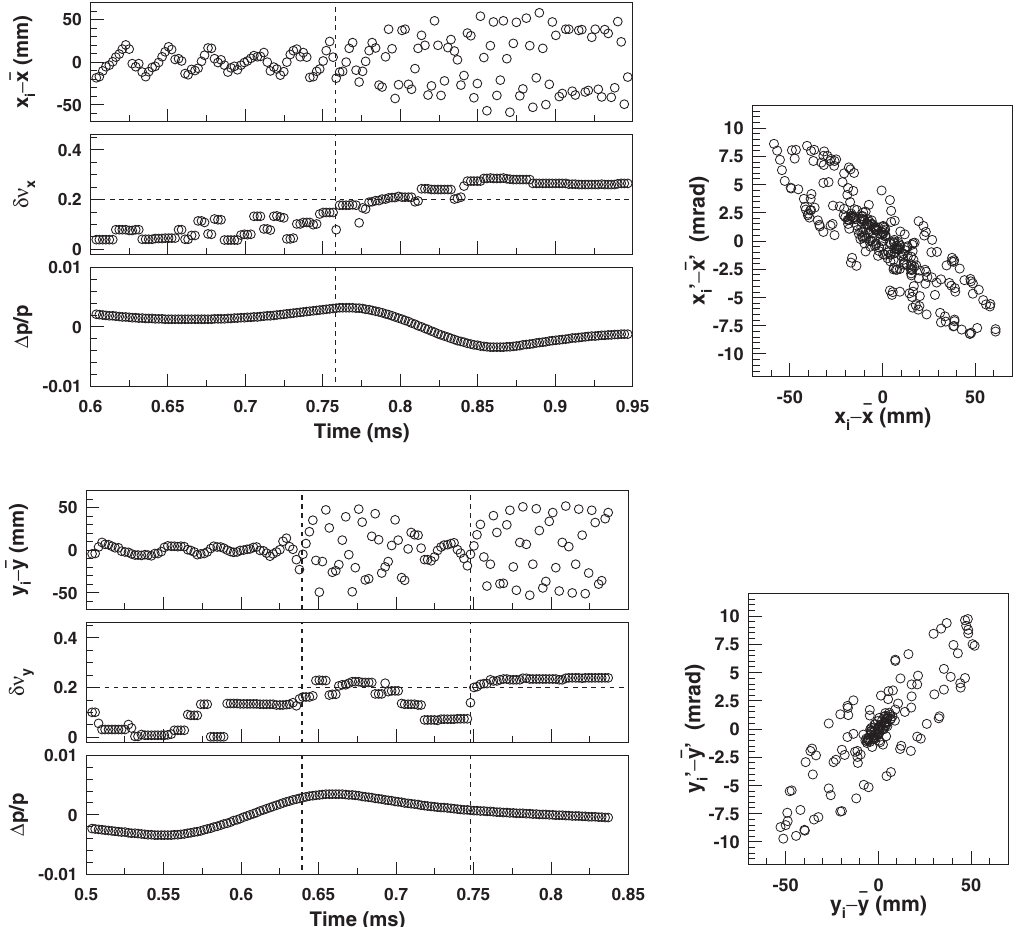
FIG. 19. Single-particle behavior of one macroparticle near 2 δν χ ¼ 0 . 4 calculated for the beam intensity of 539 kW; incoherent position χ i − ¯ χ , fractional part of incoherent tune δν χ , momentum deviation Δ p=p , and two-dimensional transverse phase-space coordinates ( χ i − ¯ χ , χ 0 i − ¯ χ 0